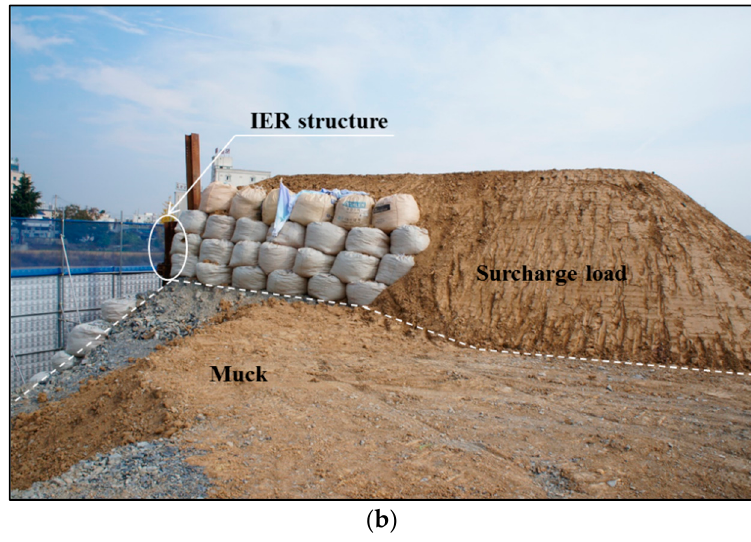
Figure 3. Field test: ( a ) IER structure and ( b ) completion of surcharge load. Table 1. Lateral displacement and lateral displacement ratio after completion of embankment [10].